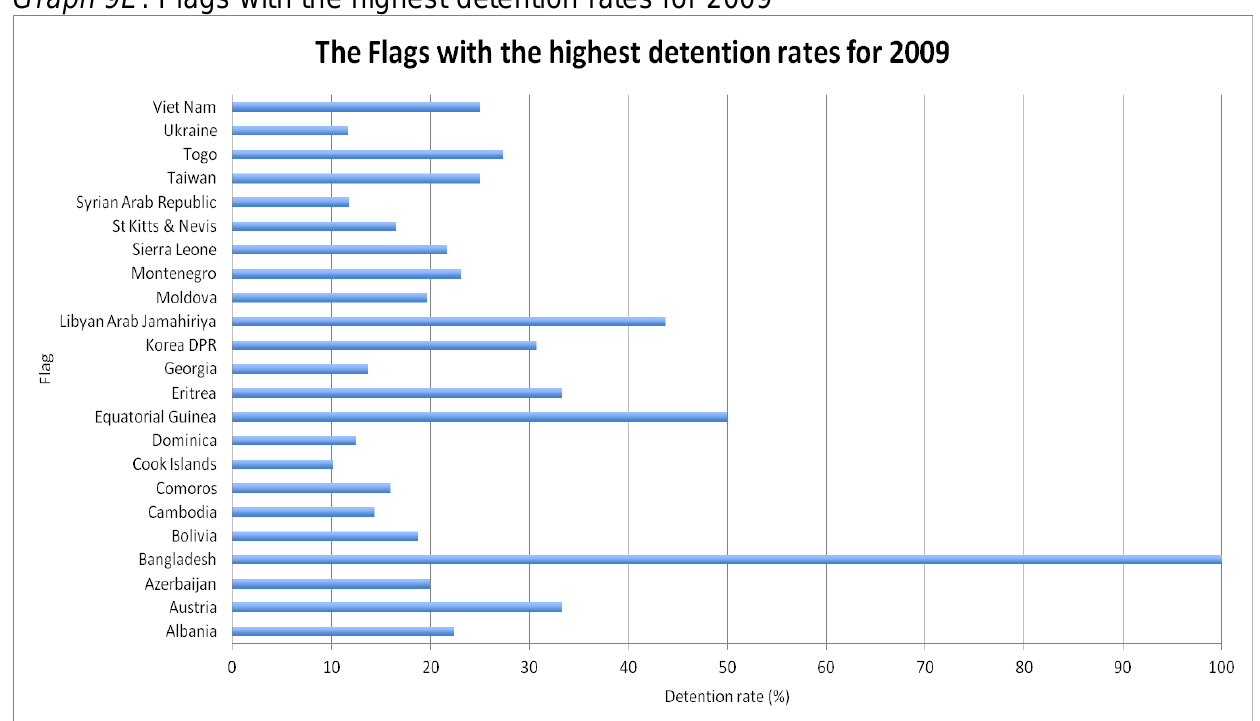
Graph 9E : Flags with the highest detention rates for 2009